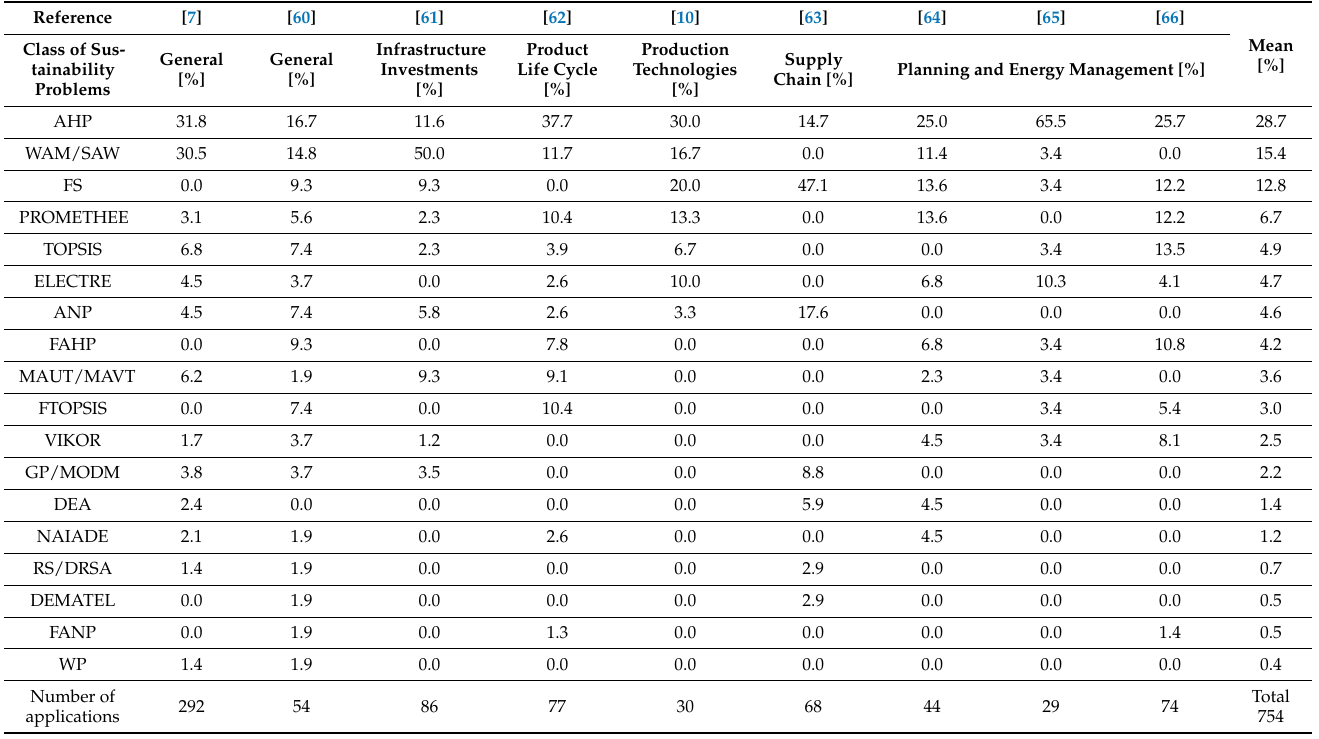
Table 2. Quantitative analysis of the applications of individual multi-criteria methods in the problems of